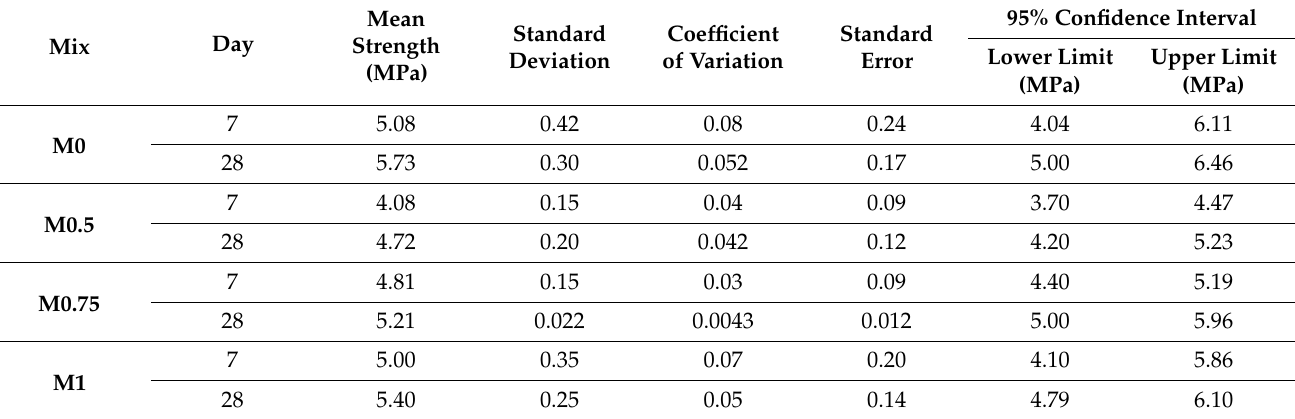
Table 9. Flexural strength test results summary.